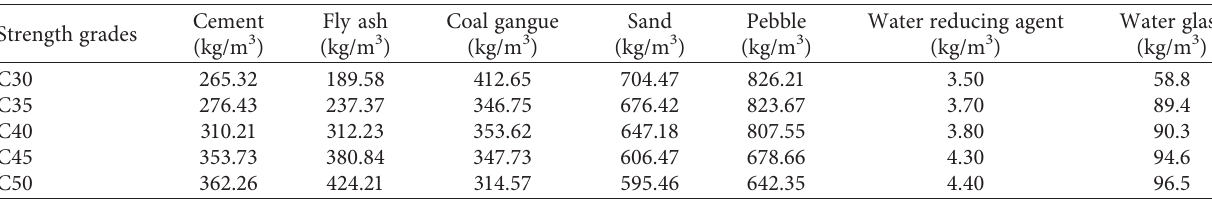
Table 8: Mix design optimization of different strength grades coal gangue-based geopolymer concrete based on logistic mapping. Strength grades